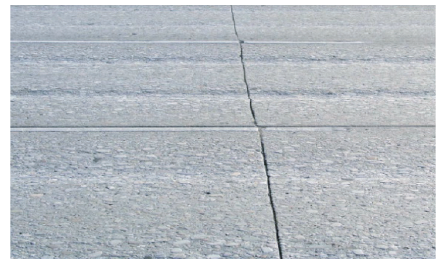
Figure 5: Surface wear in the wheel paths [12].